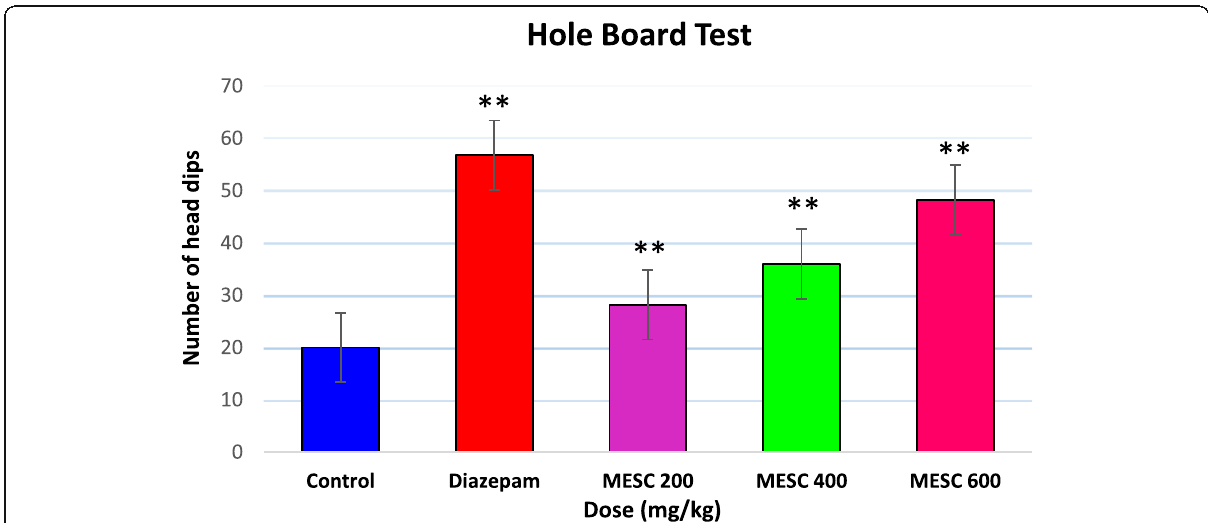
Fig. 5 The anxiolytic effect of MESC on hole-board test in mice. i. * p < 0.001 vs control group. ii.** p < 0.0001 vs control group. [Control (NaCl saline 0.1 ml/ mouse), Diazepam (1 mg/kg B.W.), MESC (200, 400 and 600 mg/kg